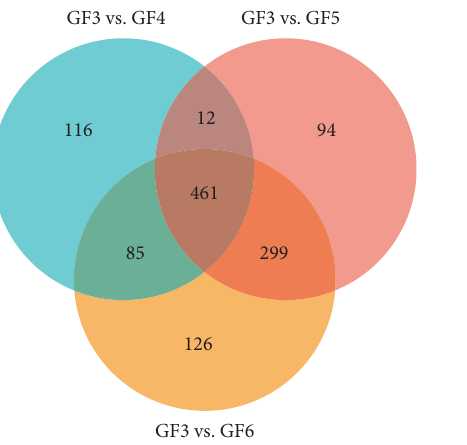
Figure 3: Venn diagram of the number of diferential compounds of GF samples from 3-, 4-, 5-, 6-yr-old. 674 diferential compounds were screened between GF3 vs. GF4, while 866 and 971 diferential compounds between GF3 vs. GF5 and GF3 vs. GF6, respectively; Among them, there are 473 diferential compounds in GF3 vs. GF4 and GF3 vs. GF5, 546 diferential compounds in GF3 vs. GF4 and GF3 vs. GF6, and 760 diferential compounds in GF3 vs. GF5 and GF3 vs. GF6.